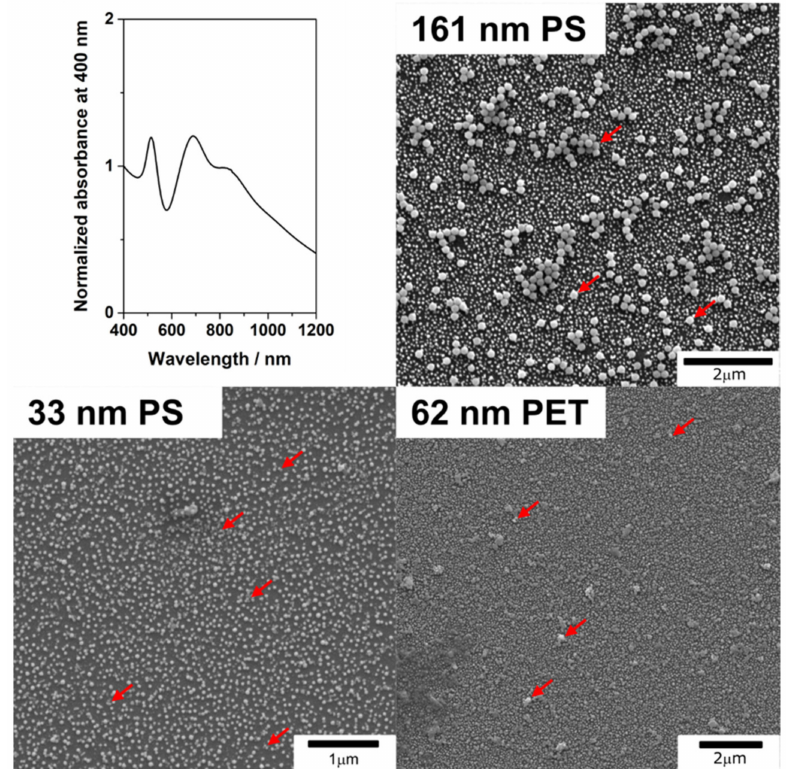
Figure 1. UV-vis extinction spectra of the 46 nm AuNP substrates and representative SEM images of the 161 nm PS, 33 nm PS, and 62 nm PET particles after their addition on top of the substrates. These images were taken at the middle of the cast drop and show that the gold and plastic particles are distributed homogenously throughout the substrate surface. Several examples of plastic particles are indicated with red arrows for clarity. See Figure A3 for additional SEM